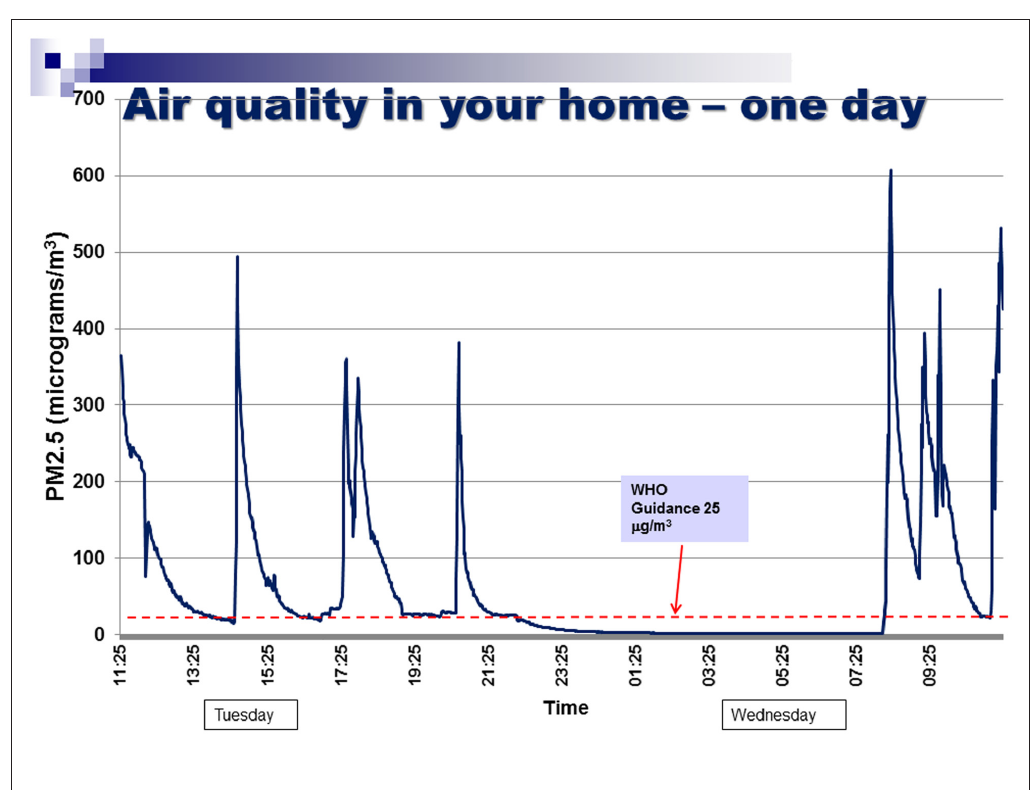
Figure 5: Examples of current feedback package at the time of the needs analysis.